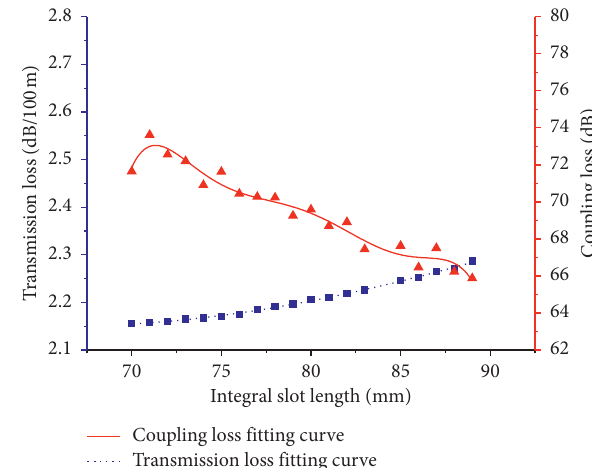
Figure 6: The relationship between the overall groove width of U- groove and cable leakage loss.